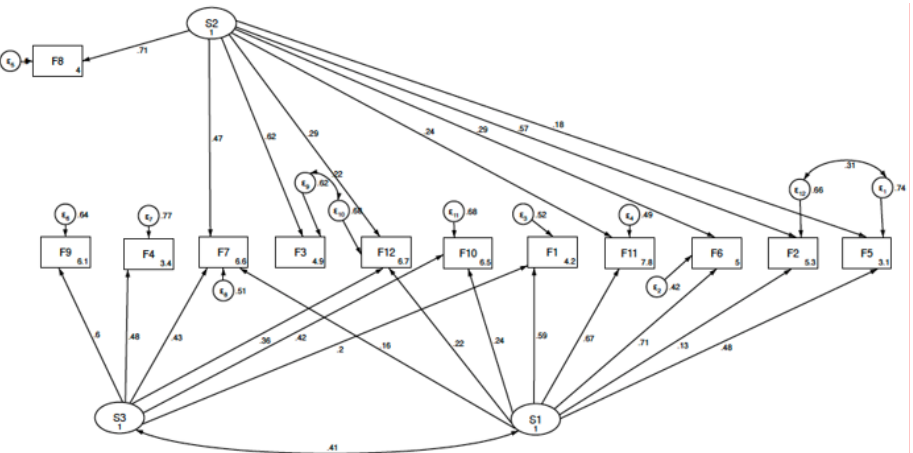
Figure 3. Second—order Factor Model F1, Supremacy; F2, Obstetric complications; F3, Psycho- Figure 3. Second — order Factor Model F1, Supremacy; F2, Obstetric complications; F3, Psychologi- logical risks; F4, Pain management; F5, Humanization; F6, Women’s decision making; F7, Birth- cal risks; F4, Pain management; F5, Humanization; F6, Women´s decision making; F7, Birth-related related trauma etilology; F8, Psychosocial risk; F9, ObScheme; F10, Accompaniment; F11, Com- trauma etilology; F8, Psychosocial risk; F9, ObScheme 10. Accompaniment; F11, Commitment; F12, Women´s expectations; S1, Ability to empathize; S2, BRT-risk management; S3 Obstetric perfor- mitment; F12, Women’s expectations; S1, Ability to empathize; S2, BRT-risk management; S3, mance. Obstetric Table 5. Structural equation models fitting índices. Chi-square